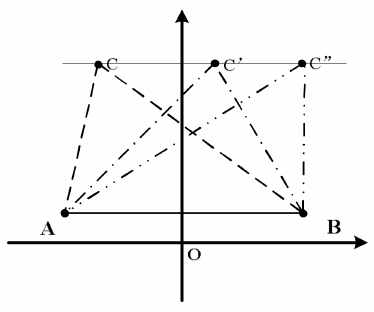
Figure 1. An example of solution